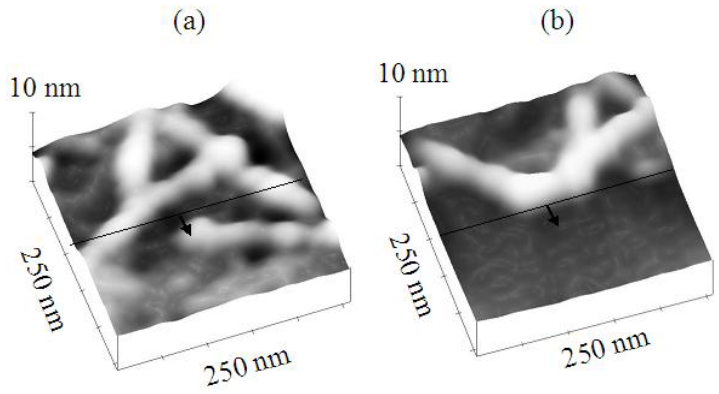
Figure 5. Comparison of the polypeptide fibril topology across the scan edge on (a) nickel and (b) HOPG substrates.